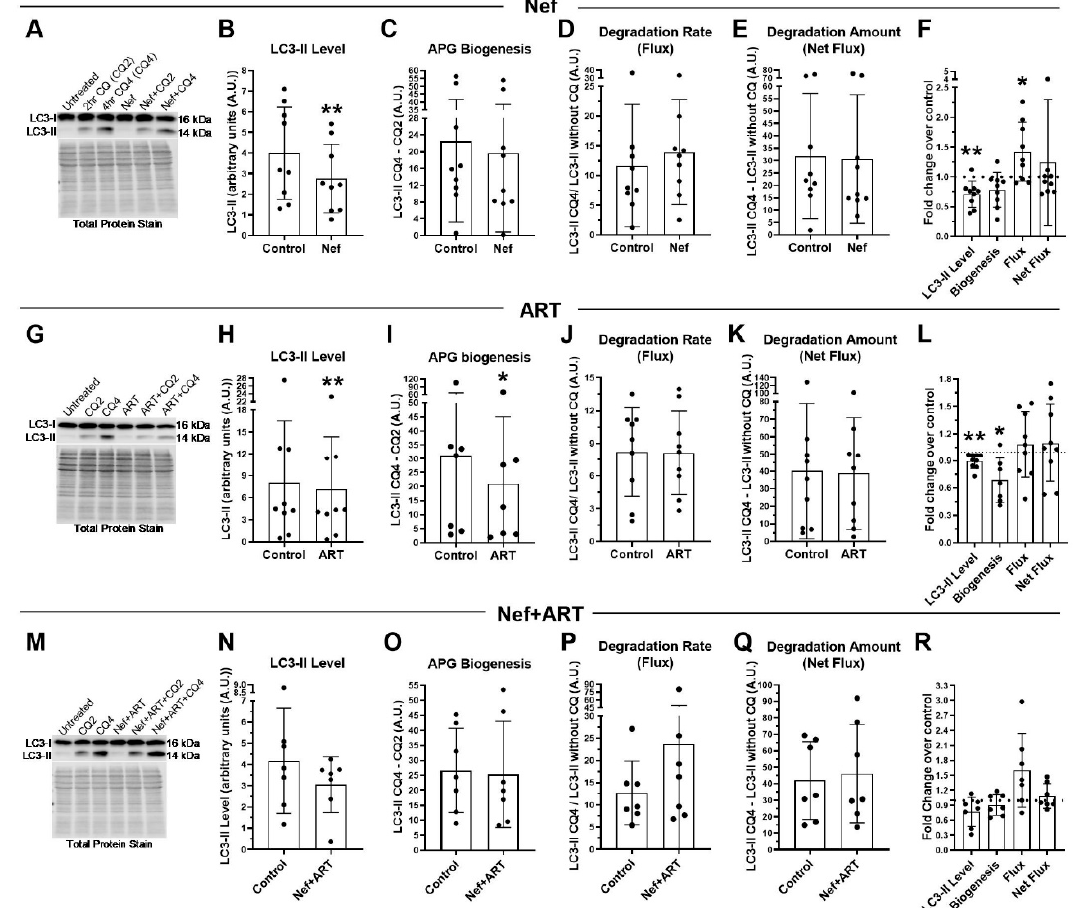
Figure 4. LC3-II steady-state level, APG biogenesis and APG degradation after treatment with Nef and / or ART for 7 days. Primary human astrocytes were treated daily for 7 days with extracellular Nef and / or ART, without and with chloroquine (CQ) for the last 2 or 4 h, then LC3 Western blotting was performed. Steady-state level, biogenesis, flux and net flux for LC3-II were calculated as described in Methods. (A , G , M ) Representative LC3-II Western blots after A. Nef, G. ART, or M. Nef + ART treatment. B-E, H-K, and N-Q show individual experiments (dots) and the means of the experiments (bars). ( B , H , N ) LC3-II steady-state level in control and B. Nef, H. ART, or N. Nef + ART treated astrocytes. ( C , I , O ) APG biogenesis in control and C. Nef, I. ART, or O. Nef + ART treated cells. ( D , J , P ) Rate of APG degradation (Flux) in control and D. Nef, J. ART, P. Nef + ART treated astrocytes. ( E , K , Q ) Amount of APG degradation (net flux) in control and E. Nef, K. ART, or Q. Nef + ART treated cells. ( F , L , R ) show the fold changes of the same autophagy parameters after treatment with F. Nef, L. ART, and R. Nef + ART over controls of individual experiments (dots) and the means of the fold changes of the experiments (bars). Controls were set to 1, represented by the dashed lines. Error bars depict SD. n = 7–11; *, p < 0.05; **, p < 0.005 by the Wilcoxon Matched-Pairs Signed Rank test or the Wilcoxon Signed Rank test.